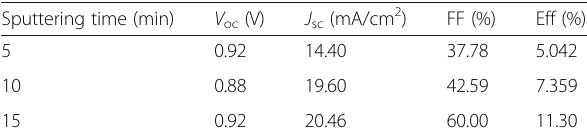
Table 2 Parameters of perovskite MAPbI 3 film on oblique ITO with various sputtering